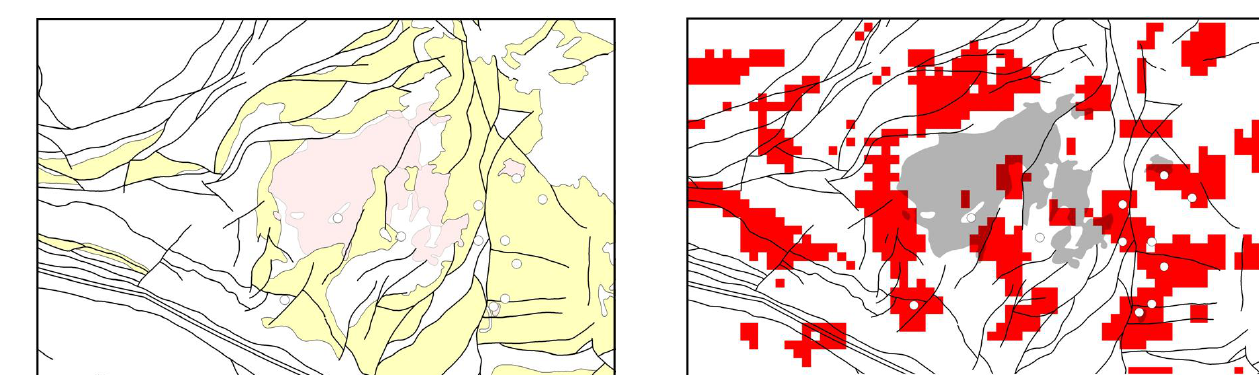
Fig. 6 Local geochemical anomalies extracted from concentration val ues of elements Sn, As, Cu, Pb, Zn and Cd. First singularity index was ca lculated from the concentration values of each element and these singularity maps were combined by means of principal component analysis. The patterns in red are the binary patterns created from the score on the first component. Details can be found in Cheng et al. (2009).